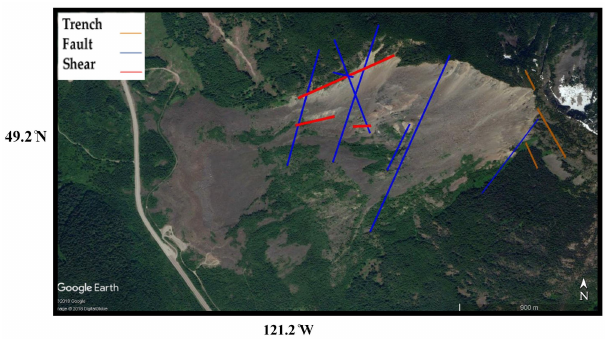
Figure 9. Hope Slide: geology map (Source: Google Earth). Trench (brown), fault (blue), and shear (red) are